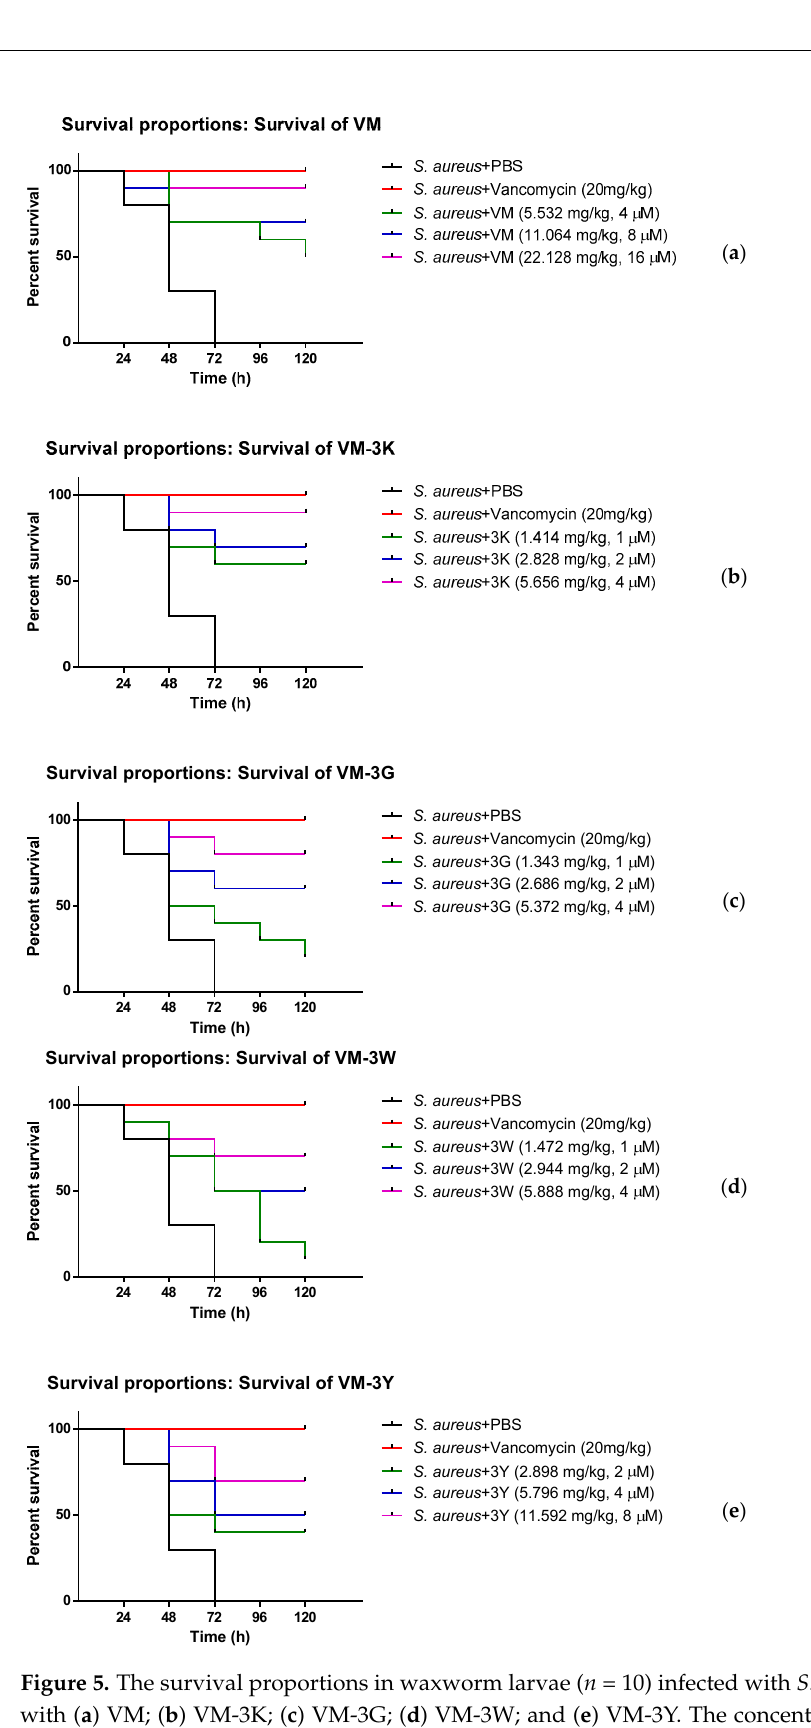
Figure 6. Assessment of the drug-resistance induction of VM and modified peptides in S. aureus after 16 passages. The X -axis represents the cycles of passage, and the Y -axis represents the MIC value of each peptide/analogue used. 4. Discussion As promising candidate drugs for the drug industry, peptides are known for their diverse functional biological activities and their flexible characteristics for research on composition and structure. In this study, a temporin peptide was chosen as a template to